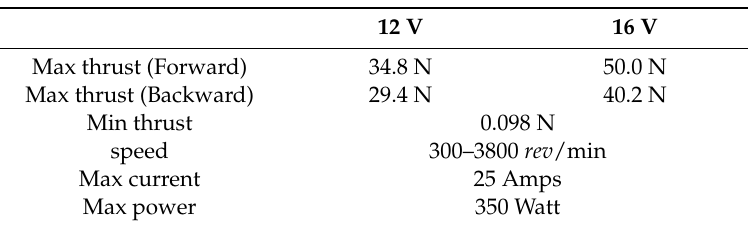
Table 1. T200 propeller characteristics.